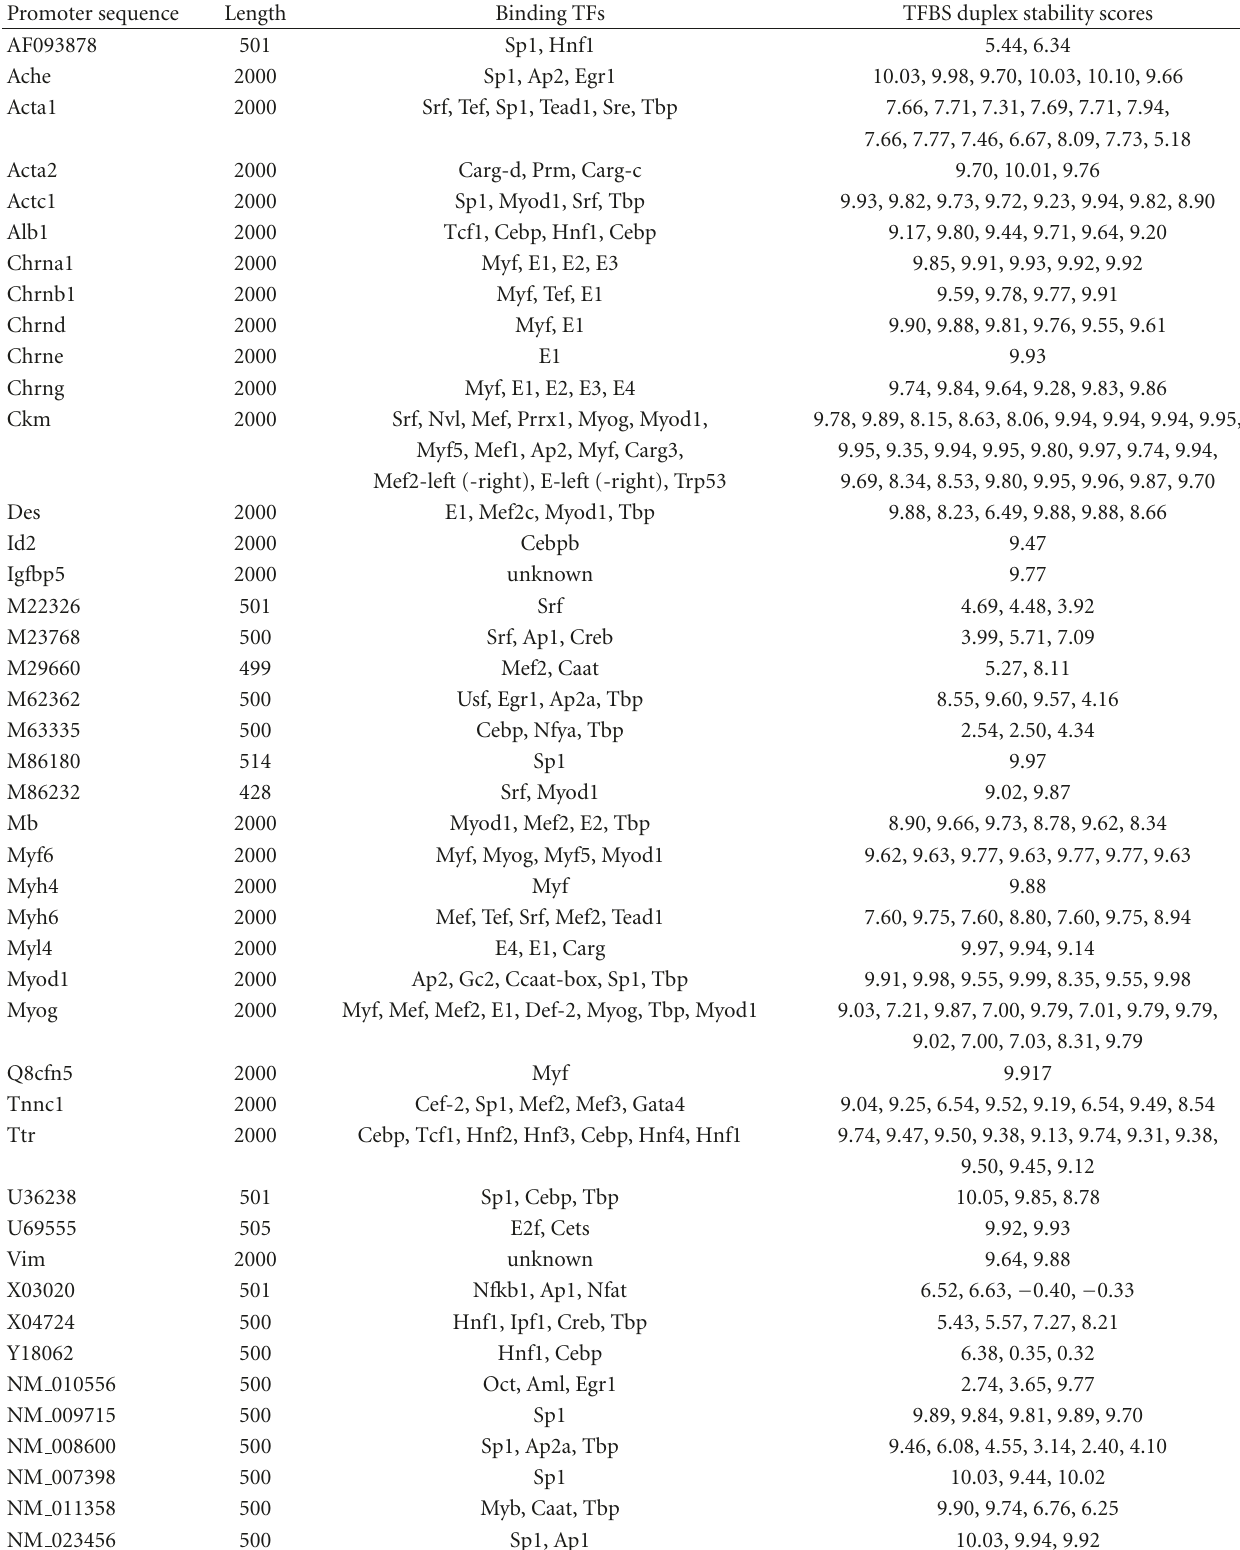
Table 2: Sequences used in this study . One “TFBS duplex stability score” is computed as the average of all the raw DNA duplex stability scores over a given TFBS. The TFBS duplex stability scores are computed for all the binding sites of a promoter sequence. Note that one sequence can have multiple binding TFs and TFBSs, one TF can bind to more than one site, and one TFBS may be recognized by multiple